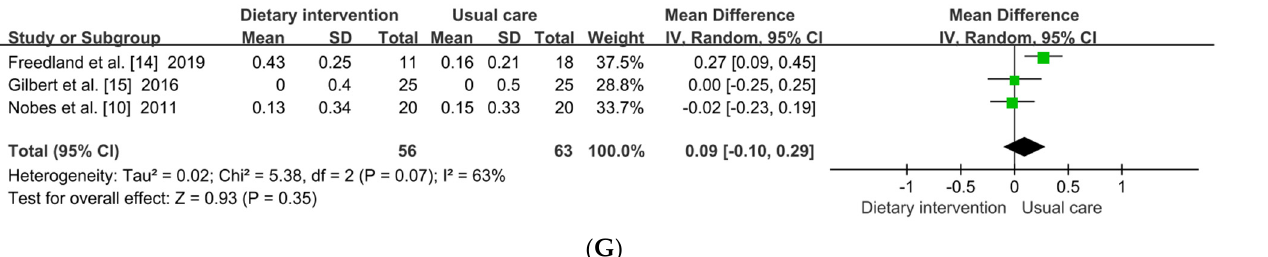
Figure 4. ( A ) forest plot of effect of healthy DP on BMI. DP, dietary pattern; BMI, body mass index. ( A ) BMI, ( A1 ) BMI subgroup, and ( B ) forest plot of effect of healthy DP on BFM. DP, dietary pattern; BFM, body fat mass. ( B ) BFM, ( B1 ) BFM subgroup, and ( C ) forest plot of effect of healthy DP on BLM. DP, dietary pattern; BLM, body lean mass. ( C ) BLM, ( C1 ) BLM subgroup, and ( D – G ) forest plot of effect of healthy DP on serum lipid profile. DP, dietary pattern; TG, triglycerides; TC, total cholesterol; LDL-C, low-density lipoprotein cholesterol; HDL-C, high-density lipoprotein cholesterol. ( D ) TG, ( E ) TC, ( F ) LDL-C, and ( G ) HDL-C. The diamond, effect size and 95%CIs; green color, weight.